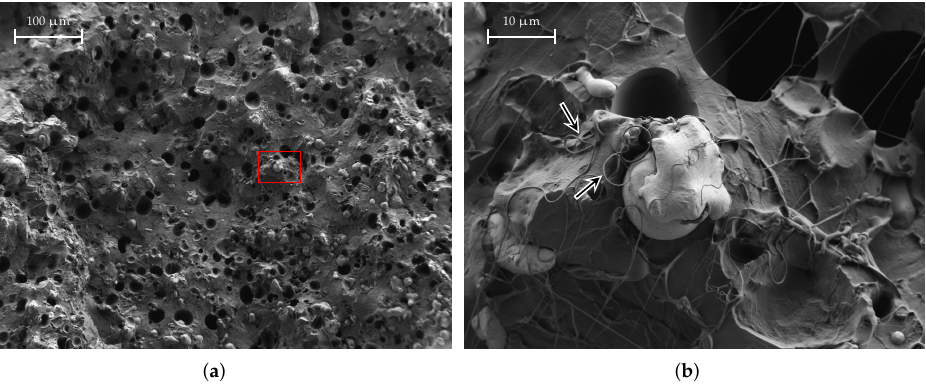
Figure 17. SEM images of a SSP material sample. The hair-like structures marked are actually PLA from breaking the filament sample apart. The red-marked area is shown enlarged on the right. ( a ) SSP, medium magnification; ( b ) SSP, large